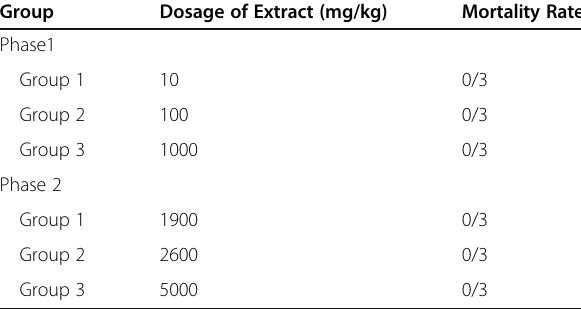
Table 2 Acute toxicity profile of Peltophorum pterocarpum Group Dosage of Extract